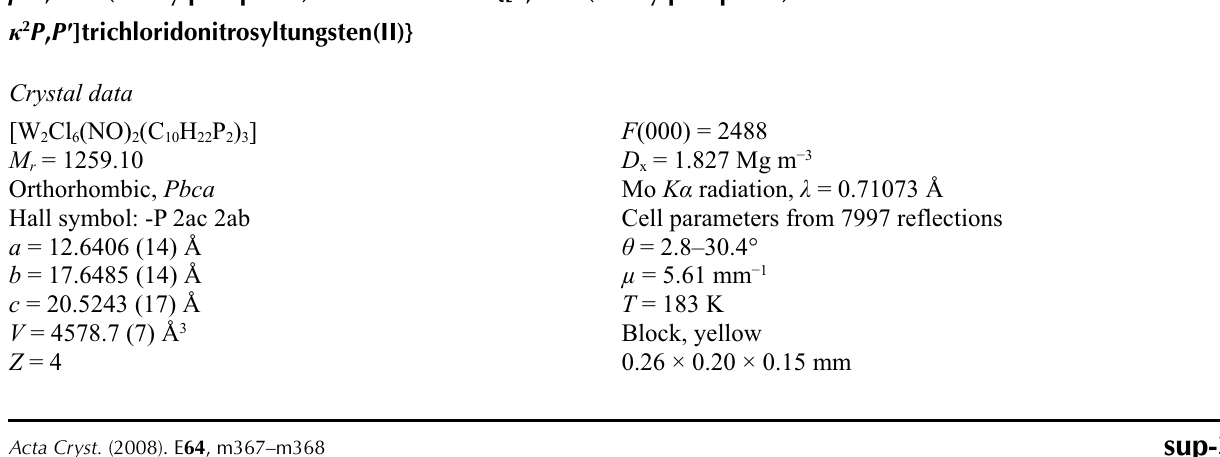
A view, along the b axis, of the crystal structure of the title compound. The intermolecular C—H···Cl and C—H···O hydrogen bonds are shown as dashed lines. Hydrogen atoms not involved in hydrogen bonding have been omitted for